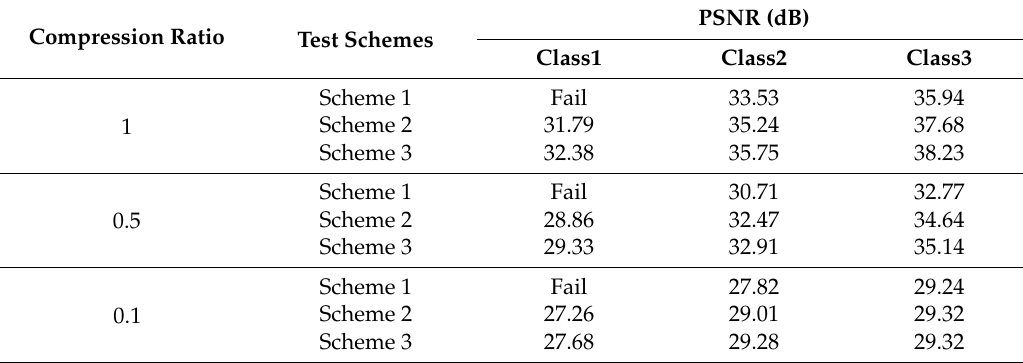
Table 6. Reconstructed image PSNR for different